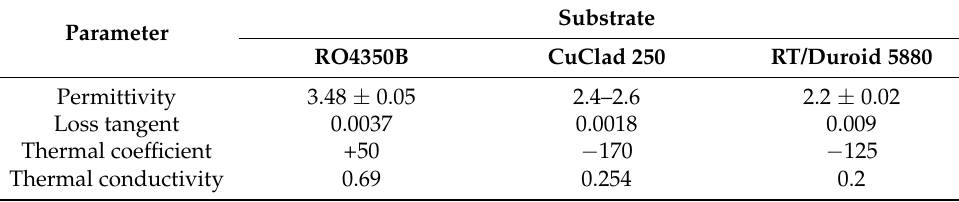
Table 1. Comparison of three well-known RF substrates showing the properties of